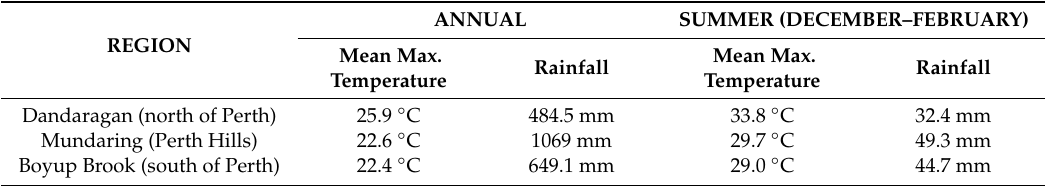
Table 2. Summary of key summary weather data for the three regions where sites are